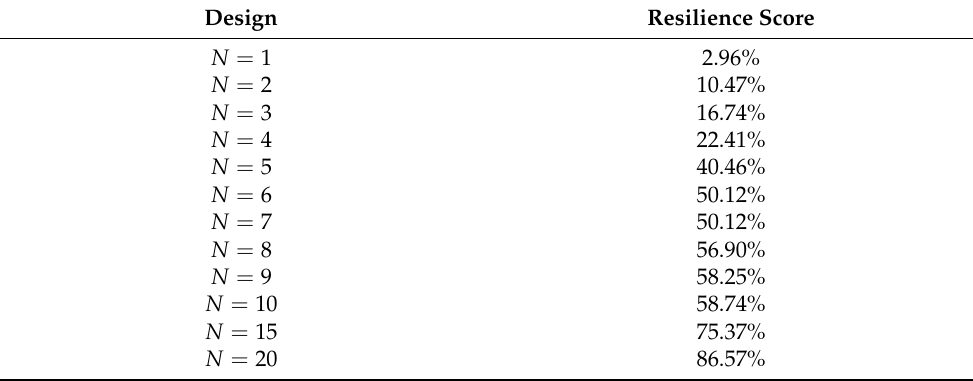
Figure 6. CWS resilience profile graphs for reliability metric DR . It should be noted that N = 6 and N = 7 curves are indiscernible. Table 3. Resilience scores for the examined sensor designs and scenarios, as measured by comparing the area under the reliability curve with the area of the ideal CWS design.